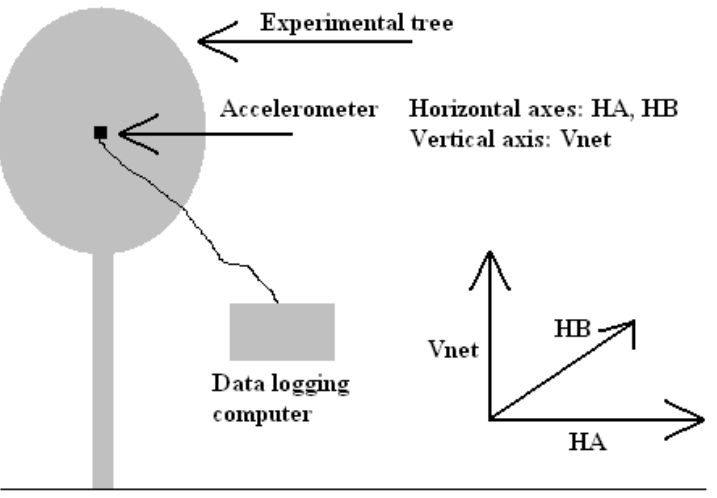
Figure 6. Inertial harvester experimental arrangement.